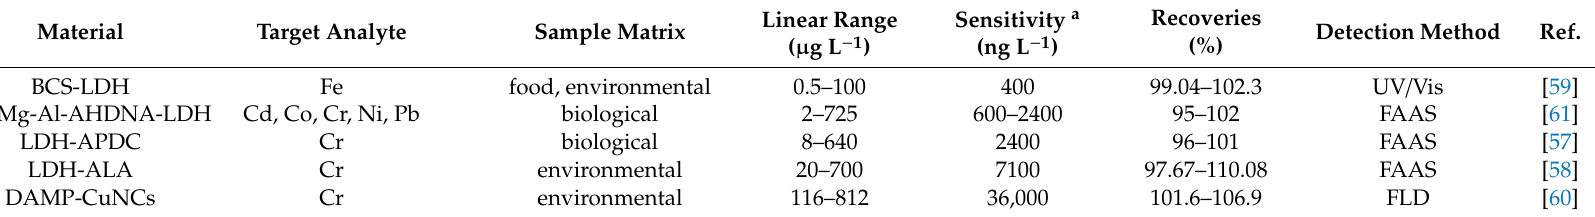
Table 5. Layered double hydroxide-based